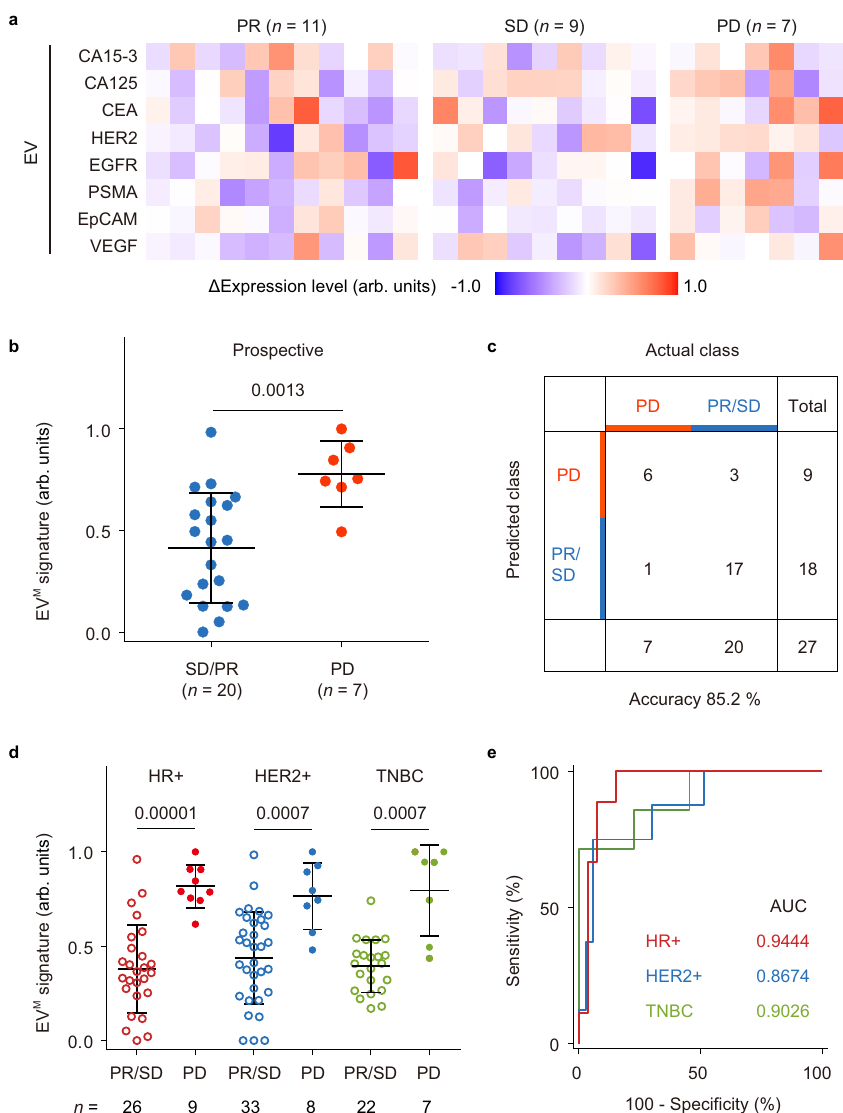
Fig. 5 Prospective cohort of MBC patients for treatment response monitoring. a Heatmap of Δ Intensity of EV protein markers in patients with PR ( n = 11), SD ( n = 9), or PD ( n = 7). b Values of the EV M signature (the weighted sum of Δ Intensity of eight markers by LDA) for SD/PR ( n = 20 samples, blue dots) and PD ( n = 7 samples, red dots) groups. c Confusion matrix showing that the EV M signature had an accuracy of 85.2% in differentiating PD from PR/SD. d EV M signature values in the HR + BC group (PR/SD: n = 26 samples, void red dots; PD: n = 9 samples, solid red dots), the HER2 + BC group (PR/ SD: n = 33 samples, void blue dots; PD: n = 8 samples, solid blue dots), and the TNBC group (PR/SD: n = 22 samples, void green dots; PD: n = 7 samples, solid green dots). e ROC curves showing similar performance of the EV M signature for classifying treatment response in different BC subtypes (HR + , red line; HER2 + , blue line; TNBC, green line). Statistical differences were determined by two-sided, nonparametric Mann – Whitney test ( b , d ). P values are indicated in the charts. Error bars represent the mean ± s.d. in ( b , d ). Source data are provided as a Source Data fi